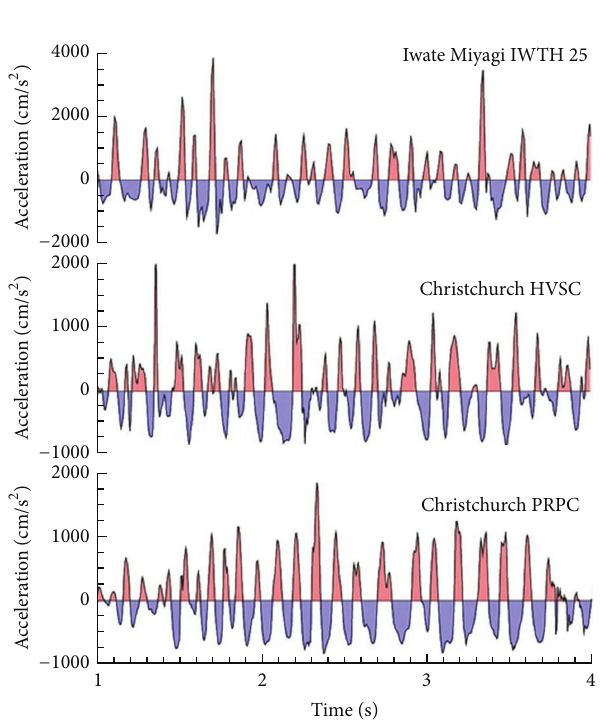
Figure 14: Magnified view of waveforms (0–4